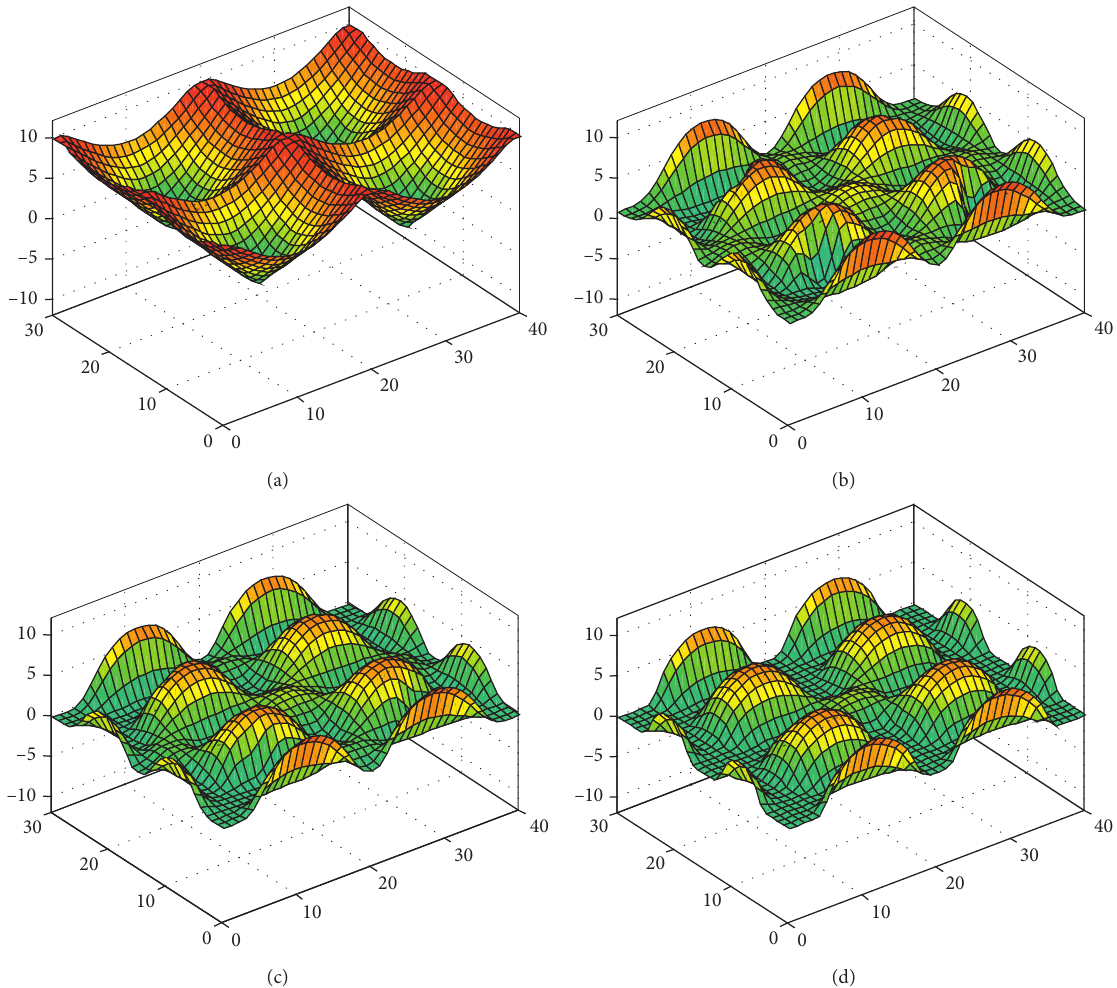
Figure 7: Evolution history of the level set surface of the damping layer for the 5th modal with four holes as the initial design. (a) Step 1. (b) Step 15. (c) Step 25. (d) Step 81.